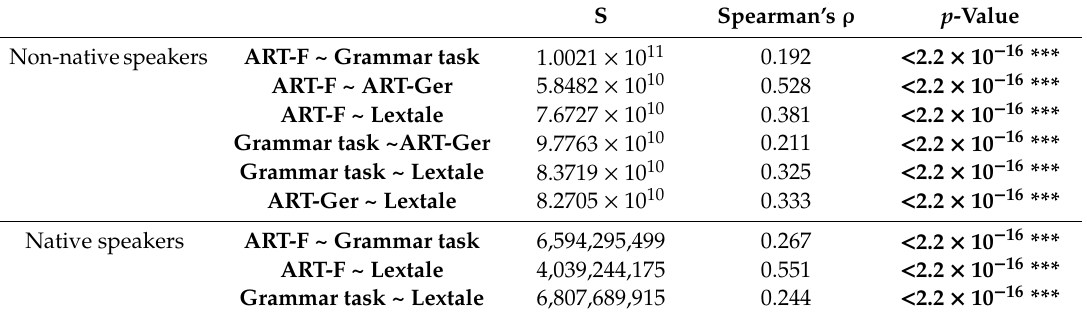
Table 9. Correlation score between the language proficiency measurements of native and non-native speakers.